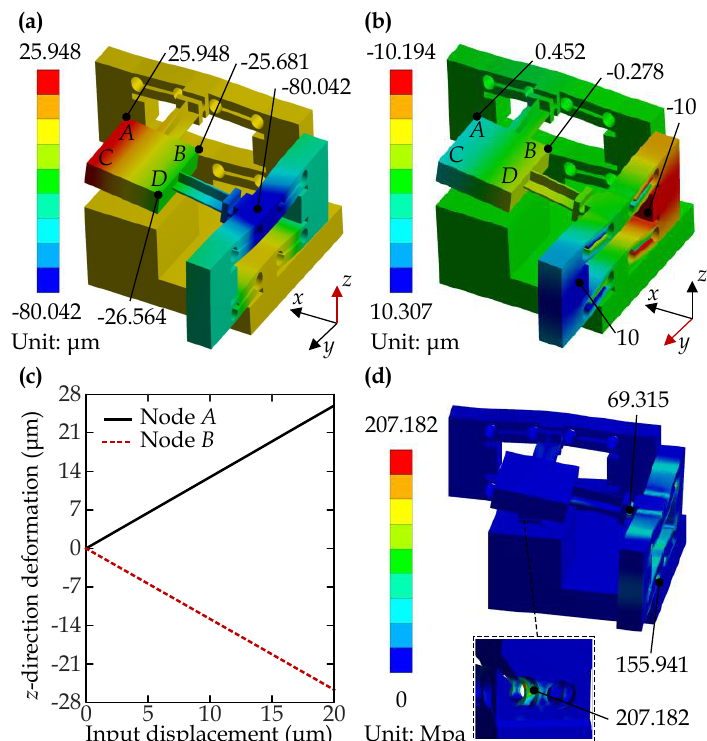
Figure 5. Static performance results in y -axis actuation without load. ( a ) z -direction deformation in y -axis actuation. ( b ) y -direction deformation in y -axis actuation. ( c ) z -direction deformation of nodes A and B in y -axis actuation. ( d ) Stress distribution in y -axis